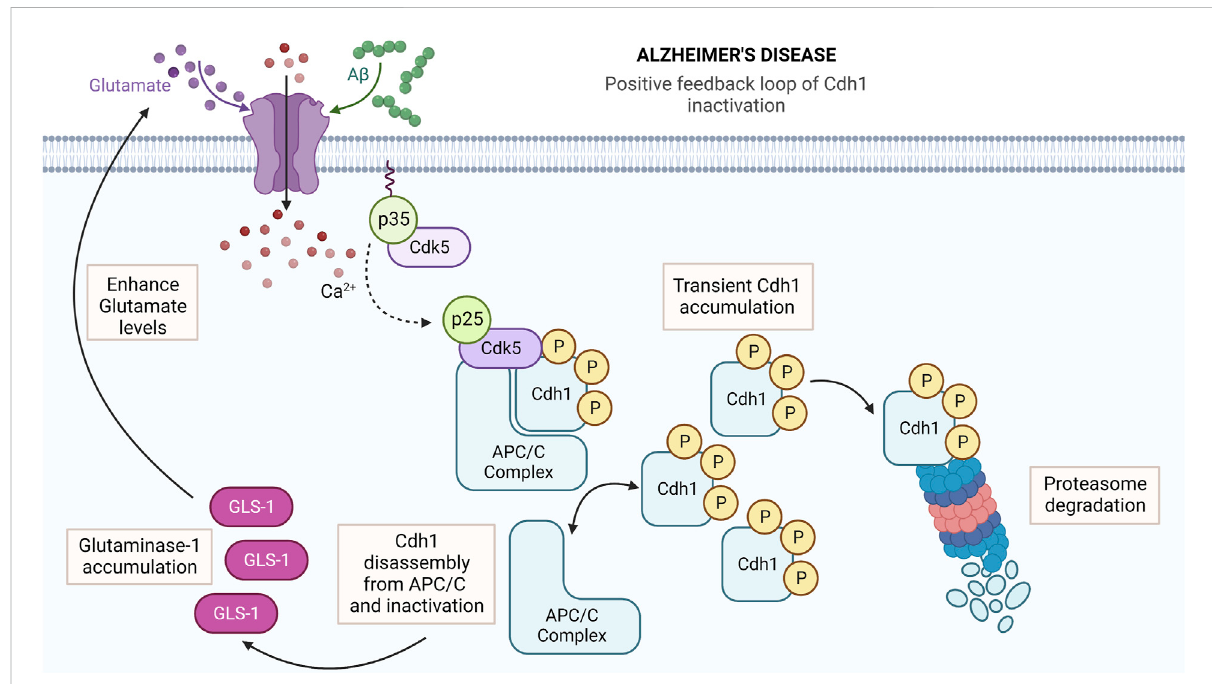
FIGURE 1 Amylod- β (A β ) induces Cdk5-dependent Cdh1 phosphorylation, which triggers APC/C-Cdh1 inactivation. In AD pathology, A β induces p35cleavedto p25bytheCa 2+ -dependentcalpainactivation.TheCdk5-p25bindingcauses Cdk5over-activation,leadingtoCdh1phosphorylation, which causes APC/C-Cdh1 disassembly and inactivation, followed by a rapid Cdh1 accumulation. However, Cdh1 protein levels underwent a progressive decrease through time due to proteasome-dependent degradation of the protein. APC/C-Cdh1 inactivation also induces the glutaminase stabilization, which in turn enhance glutamate levels and intracellular Ca 2+ in fl ux, creating a positive feedback loop of Cdh1 inactivation that potentiates neurodegeneration. Created with